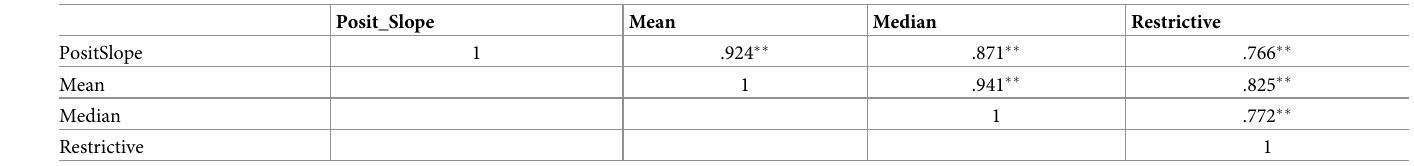
Table 3. Pearson’s